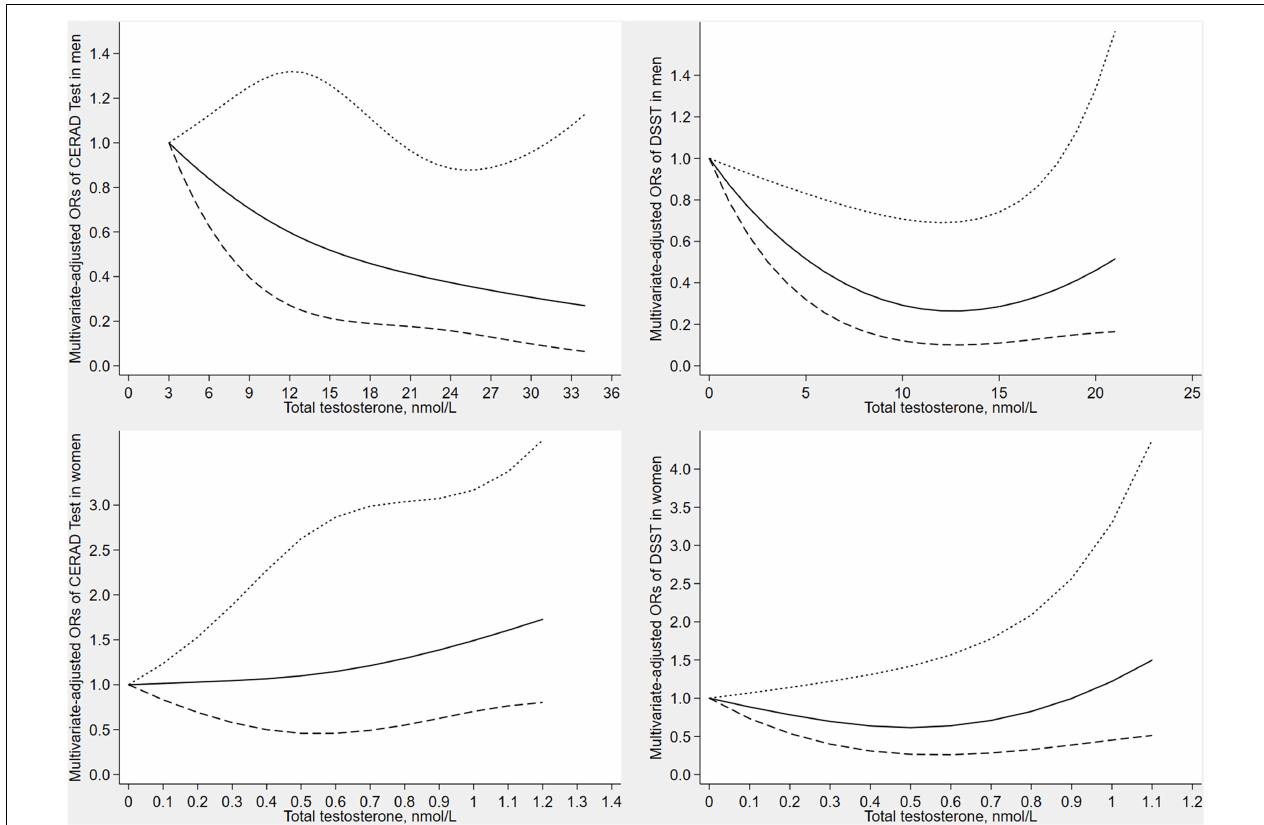
FIGURE 2 | Dose–response relationship between serum total testosterone with CERAD test score and DSST score in men and women. The solid line represents the estimated odds ratio and the area bound by the dashed lines represent the 95% confidence interval.